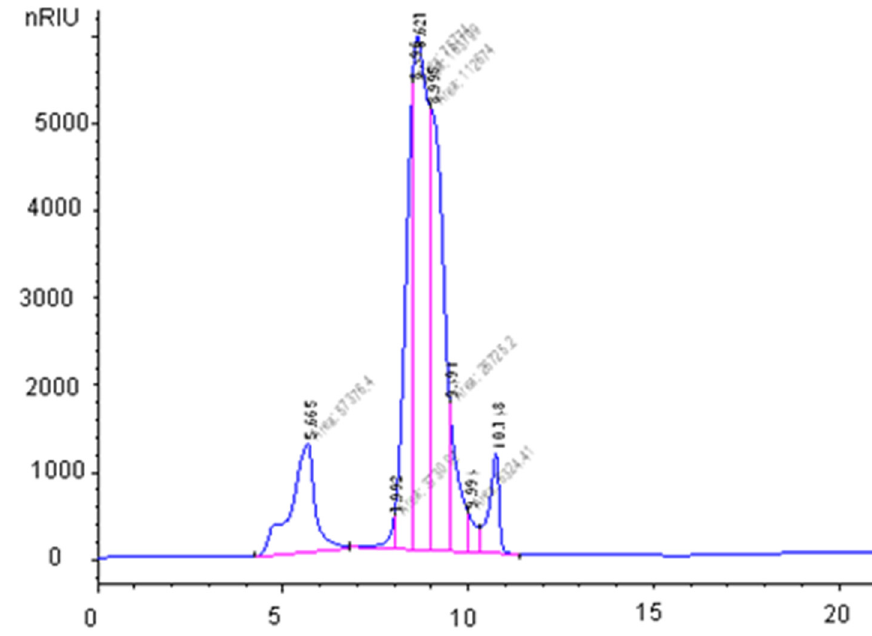
Figure 1. Chromatogram of the α -dextrin part of the FS-1 drug. Table 2. Peaks and fractions properties in the chromatogram of α -dextrins of a part of the FS-1 drug. Retention Time, min Molecular Weight,